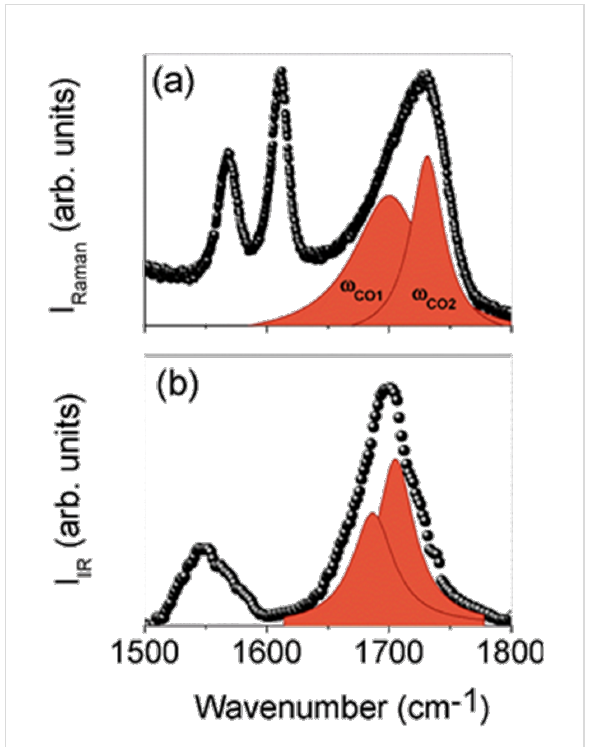
Figure 4: Raman (a) and FTIR–ATR (b) spectra of the branched β -CD-based polymer in the wavenumber range of 1500–1800 cm − 1 , together with the deconvolution components of the C=O stretching band.